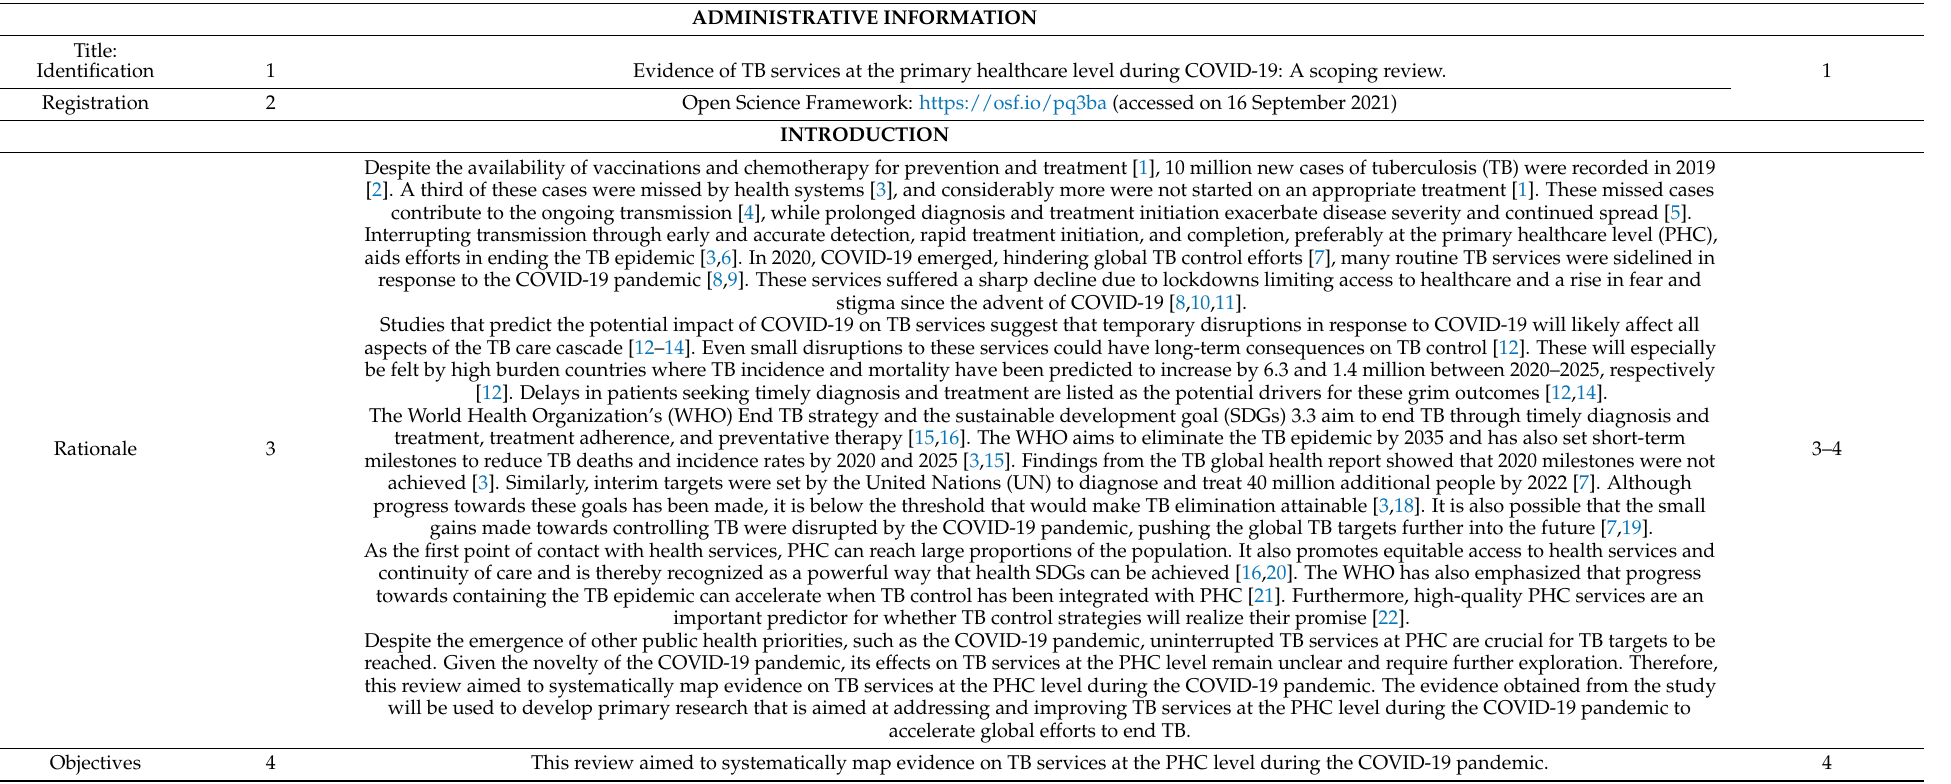
Table A1. Preferred reporting items for systematic reviews and meta-analyses extensions for scoping reviews (PRISMA-ScR) checklist. Section and